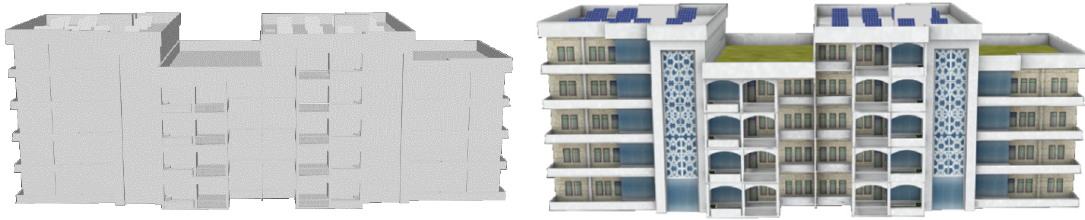
Figure 10. The Binary Large Object (BLOB) conversion parameters ( left ) and CityGML export parameters ( right ).